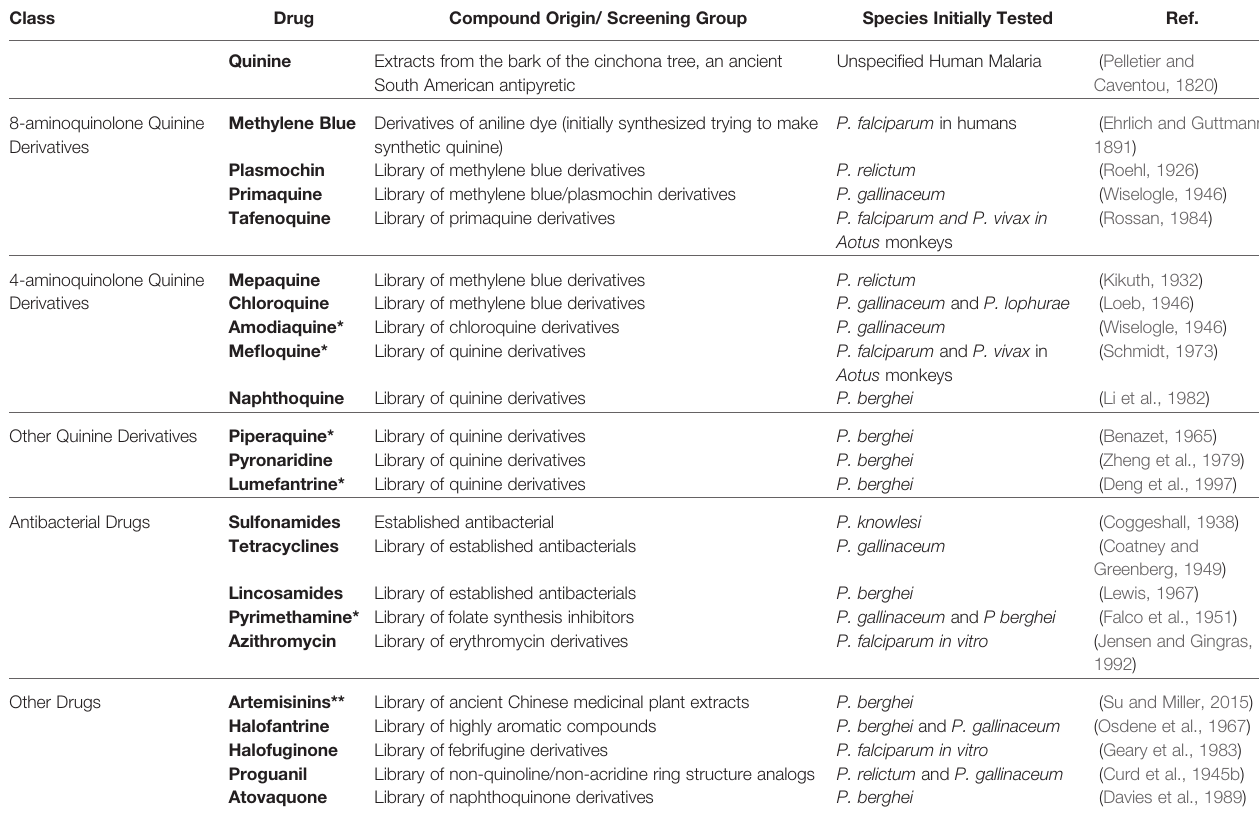
TABLE 1 | Discovery methods of select antimalarial